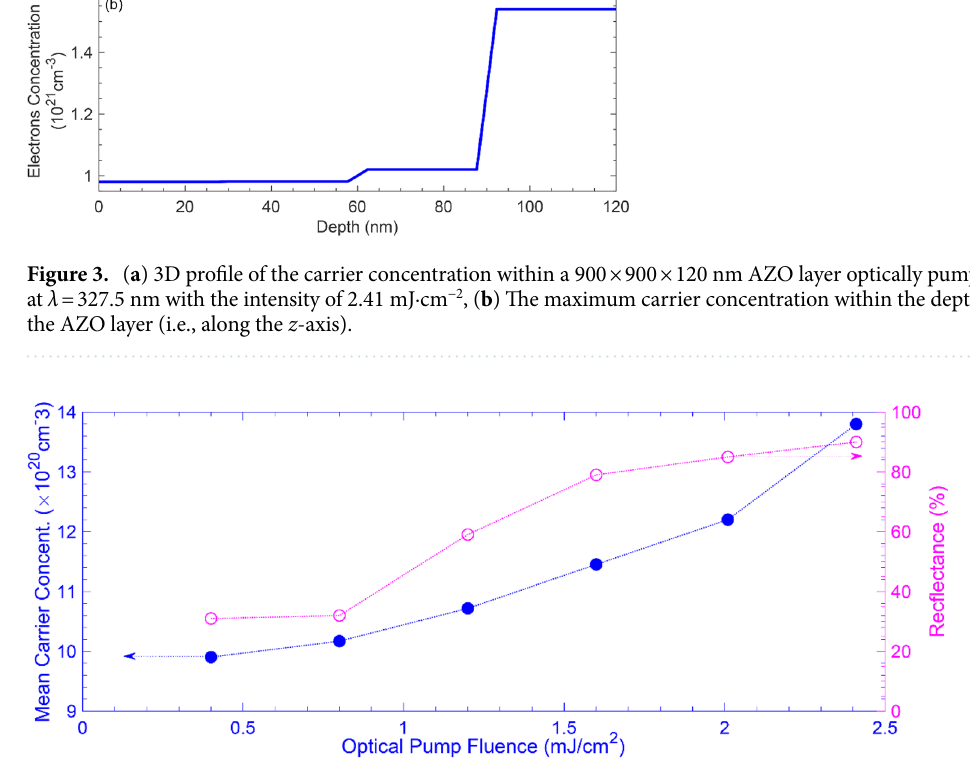
Figure 4. The mean carrier concentration in the AZO layer (solid blue circles read from the left axis) and the modulator reflectance spectra (open pink circles read from the right axis) versus the optical pump fluence.